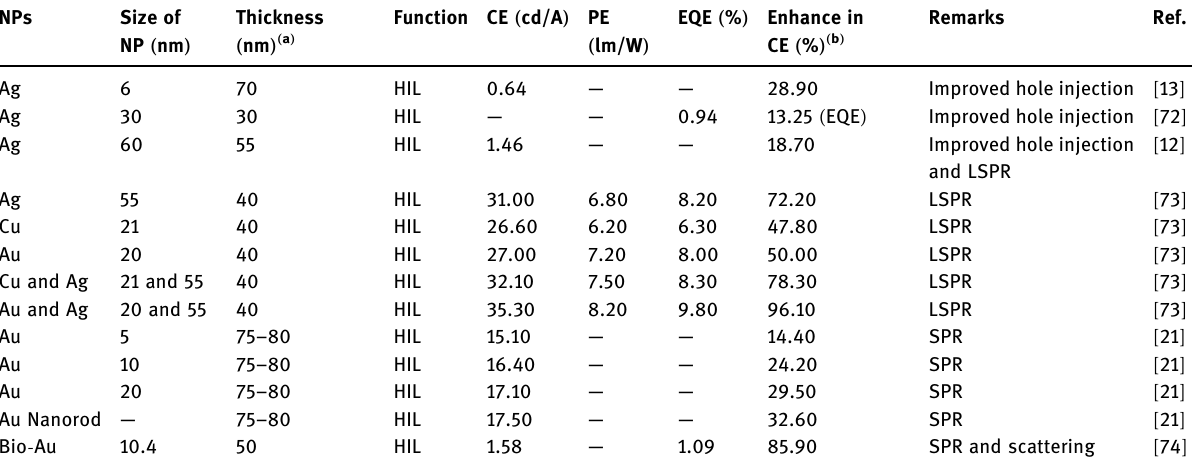
Table 1: Device characteristics of OLEDs with metallic - based NPs - doped PEDOT:PSS NPs Size